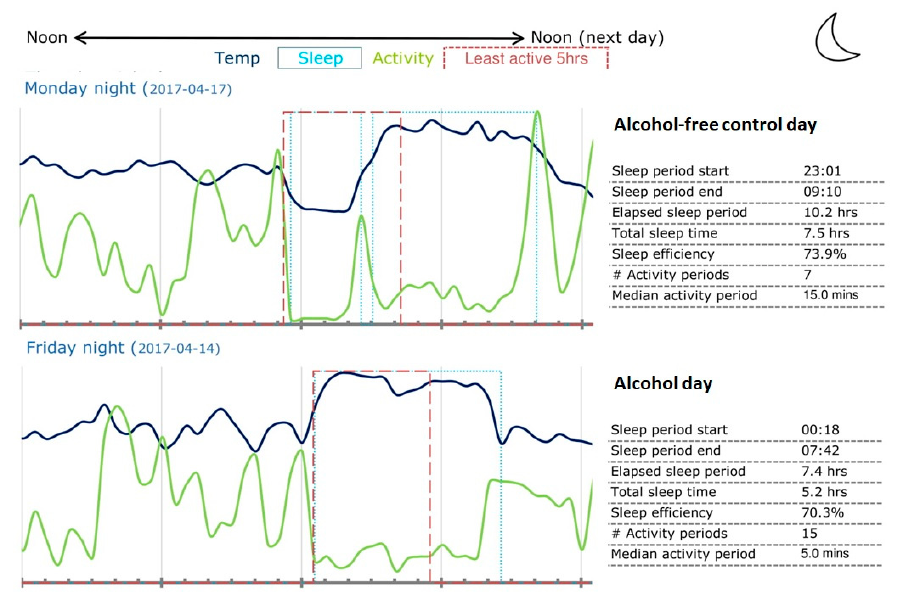
Figure 1. Visual output and summary data provided by the GENEActiv.